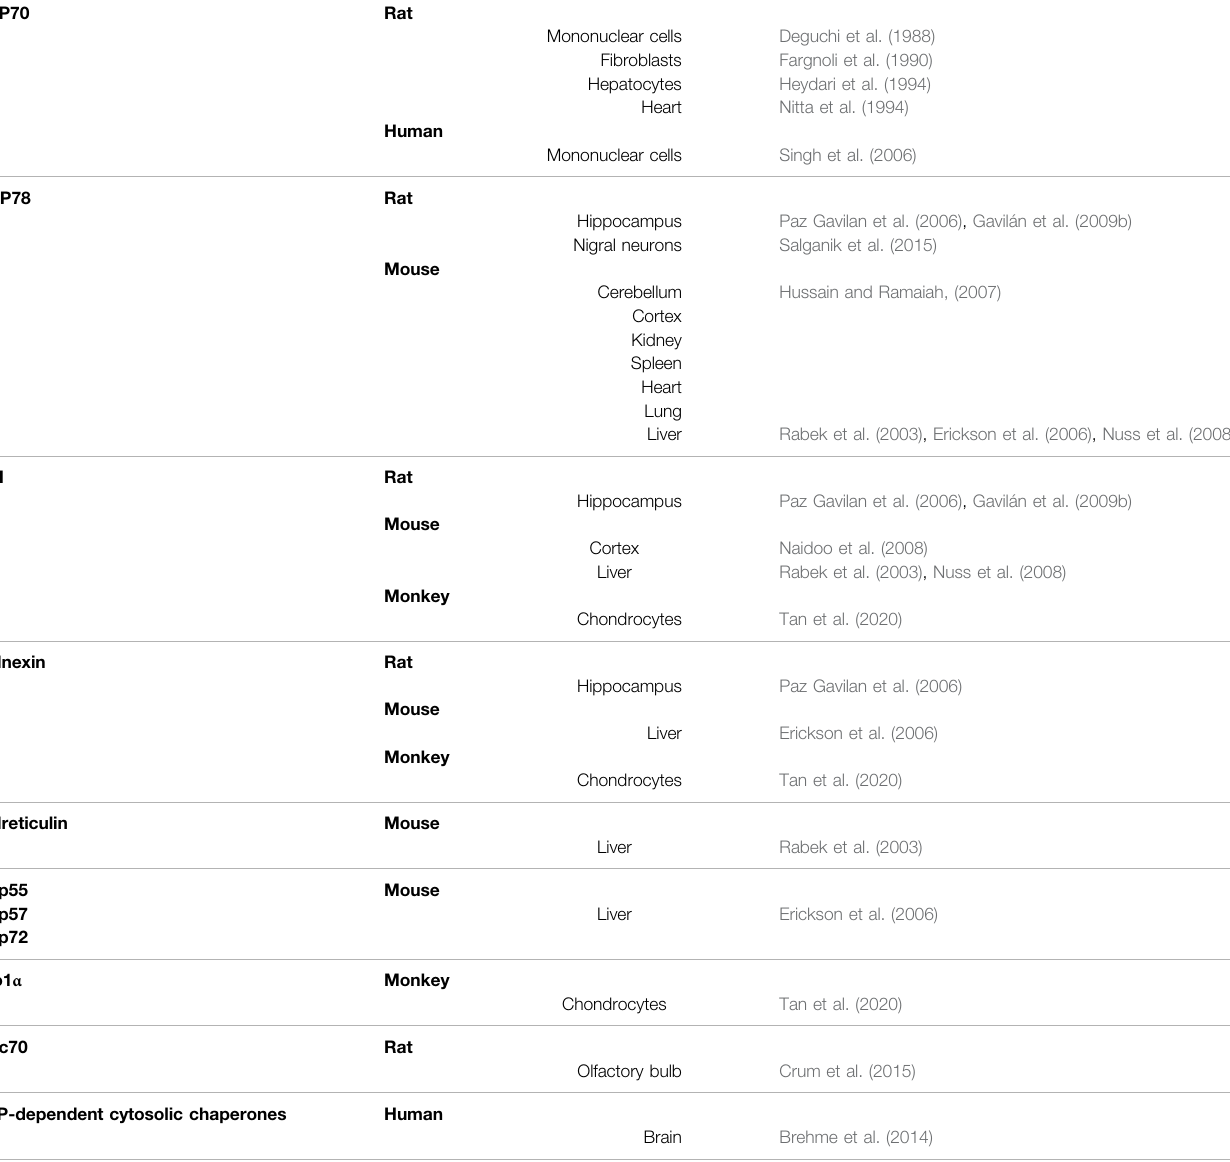
TABLE 1 | Representative molecular chaperones affected by aging in different tissues and